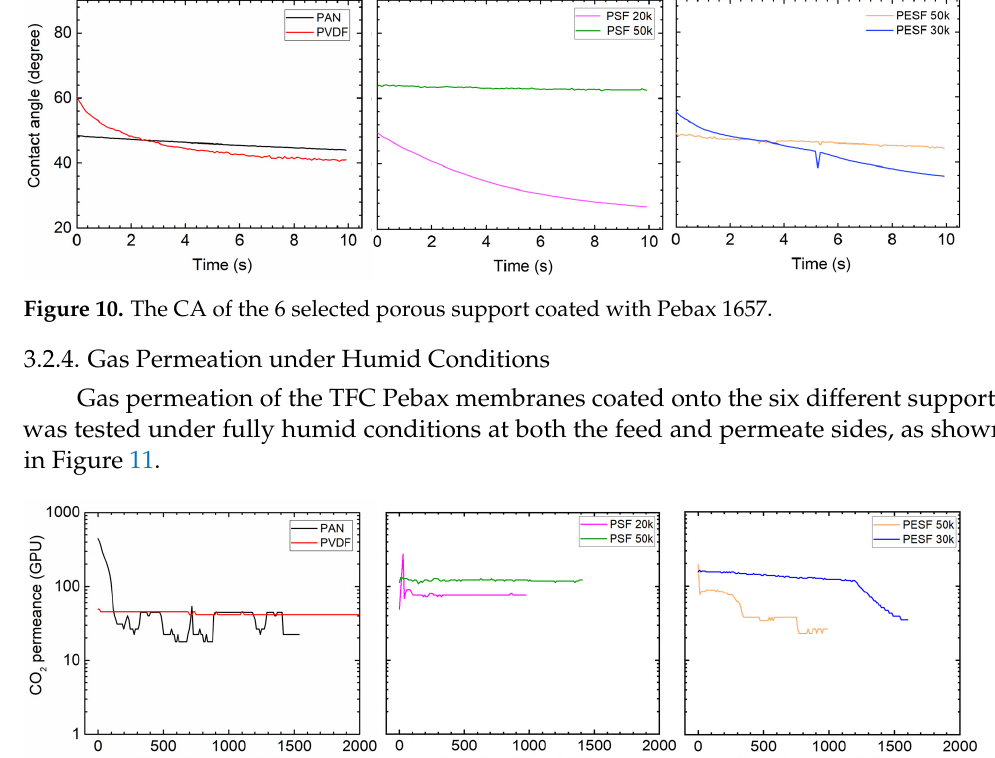
Table 2. The selective layer thickness of the Pebax TFC membrane fabricated on various supports.